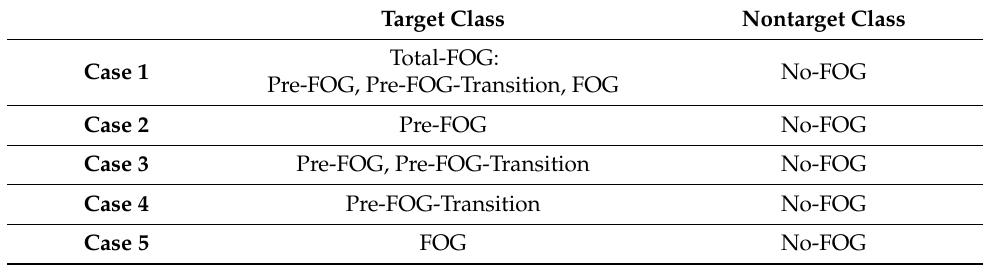
Table 2. Target and nontarget class composition for each test